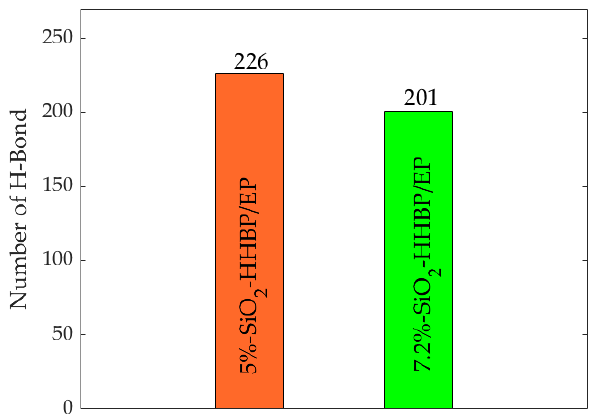
Figure 10. Number of hydrogen bonds of model under different concentration of silica.